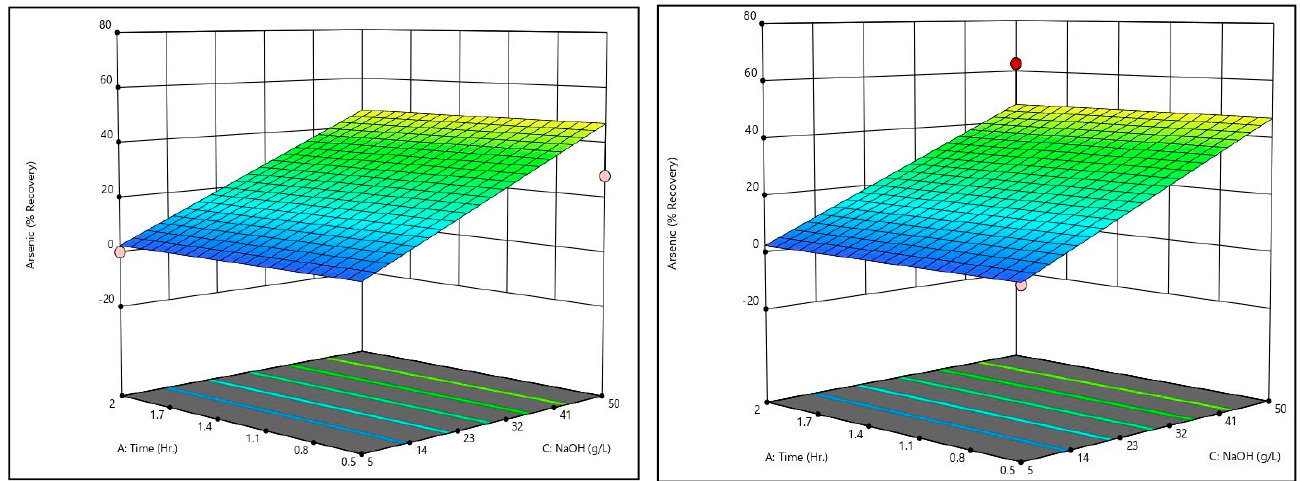
Figure 9. Caustic leaching arsenic recovery response surfaces: low temperature ( left ) and high temperature ( right ).